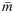
Shape of the concentration-prophylaxis profile.Colored lines depict the concentration-prophylaxis profile for an average drug class-specific slope parameter m‾ in Eq (10). Solid colored line for an inoculum of one virus Y0=V^ and dashed colored line for an inoculum of Y0=100⋅V^. Shaded areas indicate the concentration-prophylaxis profile for the smallest mmin and largest class-specific slope parameter mmax for the respective drug class as indicated in Table 2. A: Co-receptor antagonists. Currently only one co-receptor antagonist, maraviroc, is approved. We use m‾=mmin=0.61 and also plot mmax = 1 as a reference. B: Non-nucleoside reverse transcriptase inhibitors (NNRTIs); m‾=1.71, mmin = 1.55 and mmax = 1.92. Nucleoside reverse transcriptase inhibitors (NRTI) have been analyzed in [18]. C: Integrase inhibitors, m‾=1.12, mmin = 0.95 and mmax = 1.3. D: Protease inhibitors; m‾=2.87, mmin = 1.81 and mmax = 4.53. Utilized virus dynamics parameters are stated in Table 1.